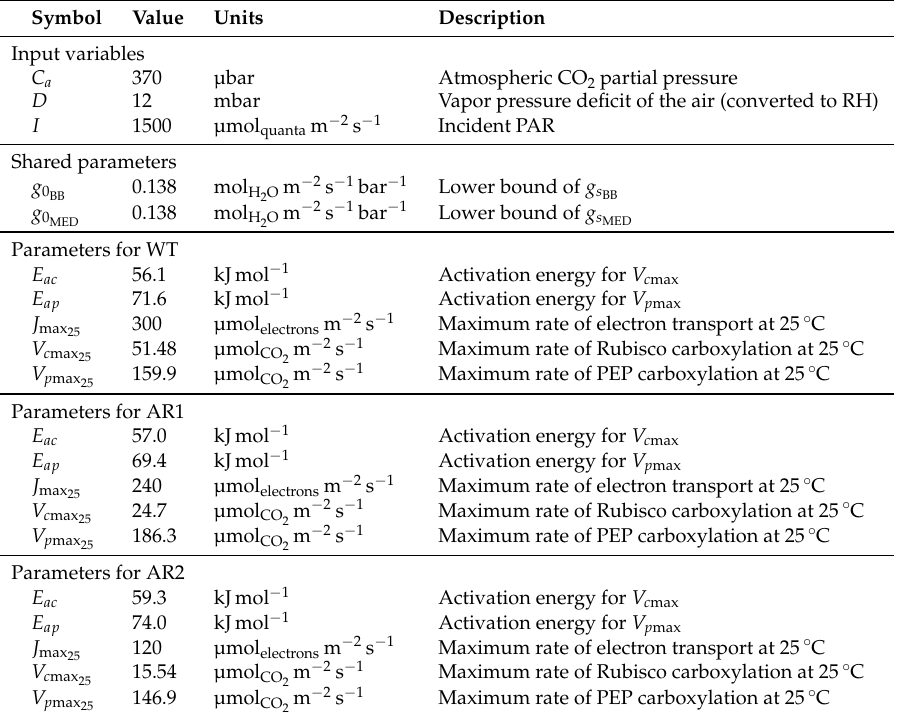
Table A3. Variables and parameters for replicating experiment by Kubien et al.